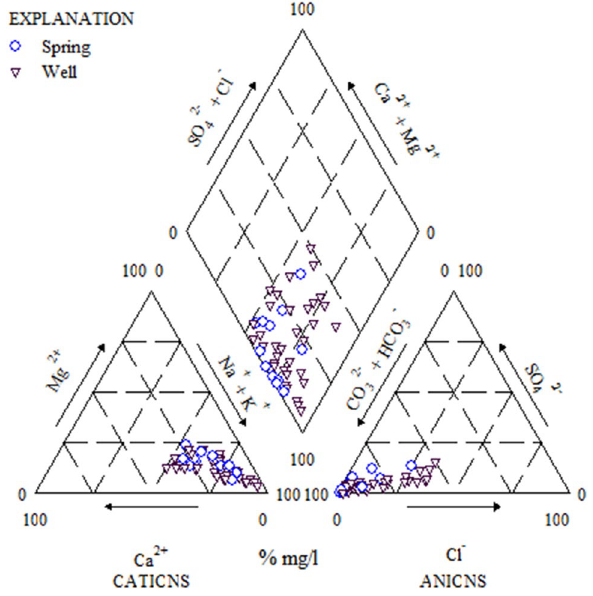
Fig. 5 Piper diagram for chemical composition of groundwater in the study